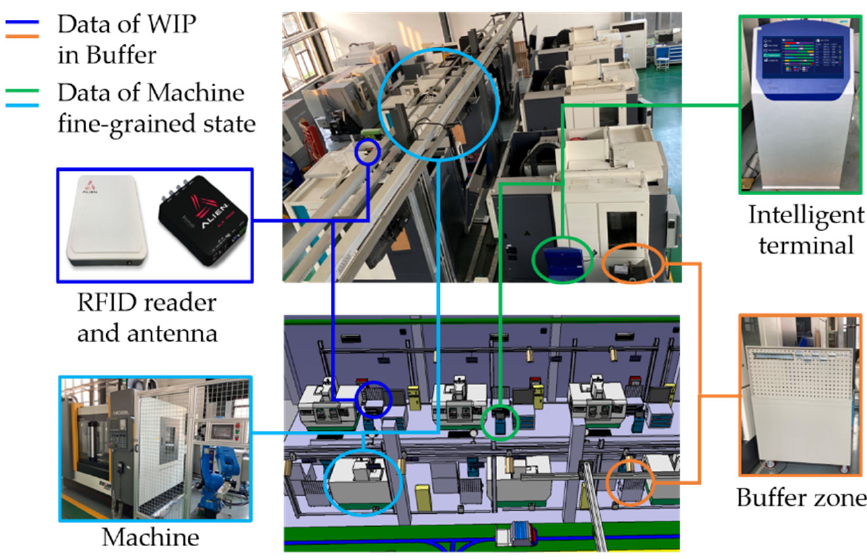
Figure 10. The layout of the discrete smart shop floor and simulation model.